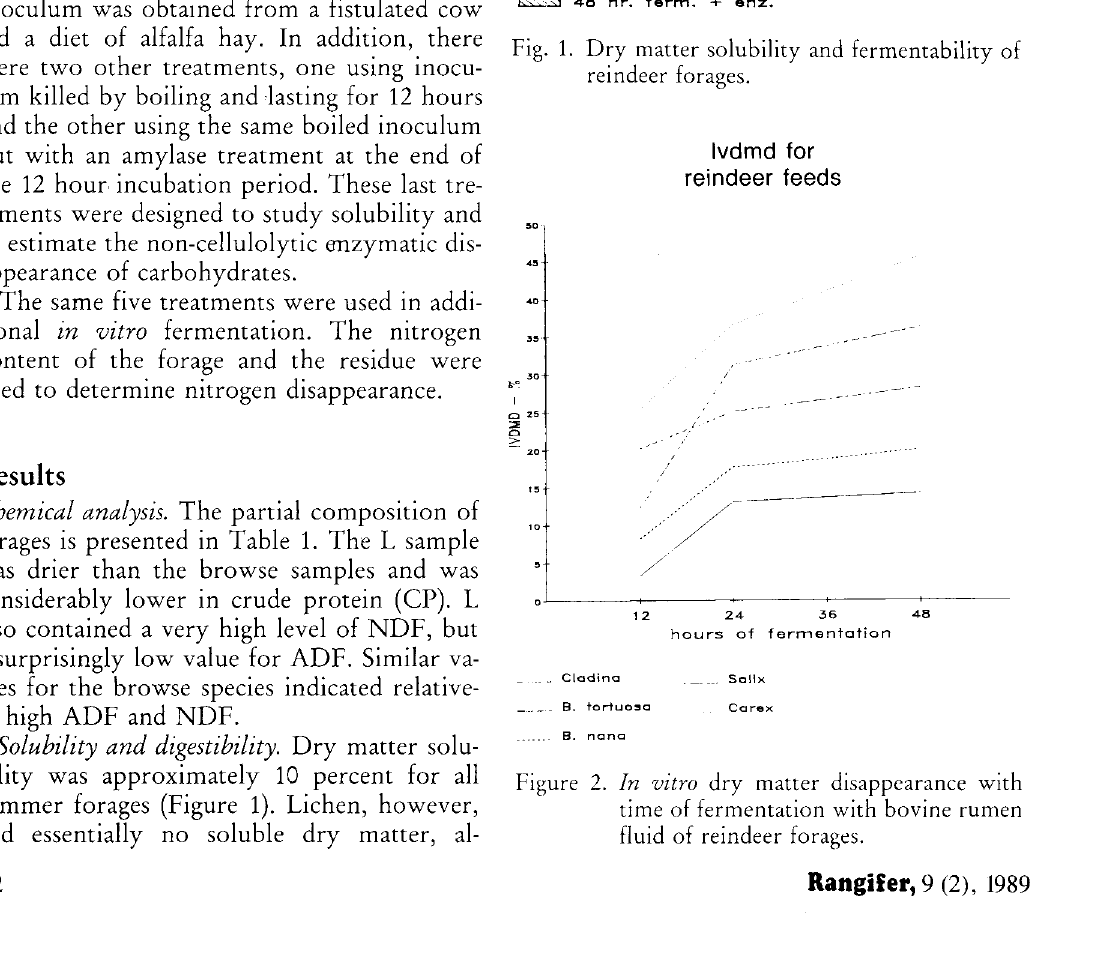
Fig. 1. Dry matter solubility and fermentability of reindeer forages.